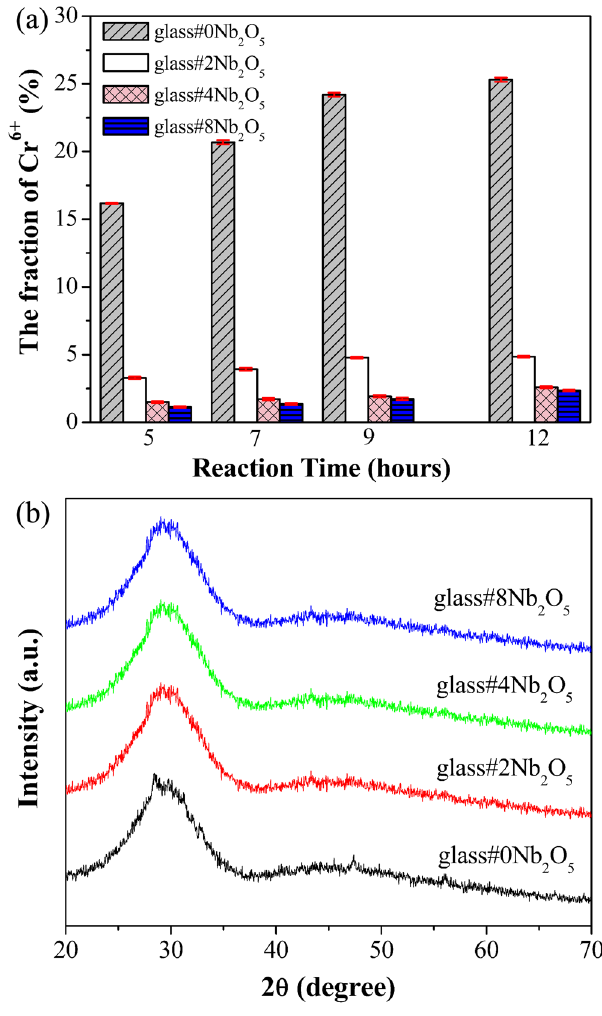
Figure 4. ( a ) Quantitative results of the Cr 2 O 3 /glass reaction couples held in air at 650 °C. ( b ) XRD patterns of the glass held at 650 °C for 20 h.